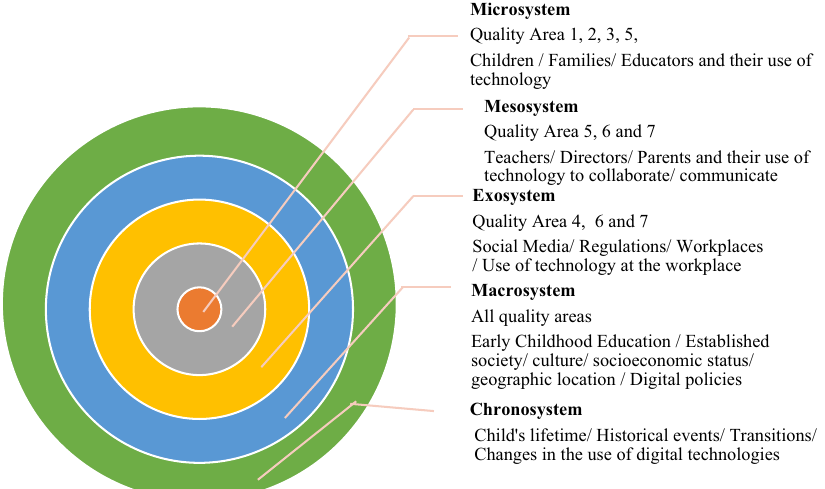
Fig. 1 A visual representation of the main systems of the ecological theory and the alignment with the NQS Quality Areas and use of